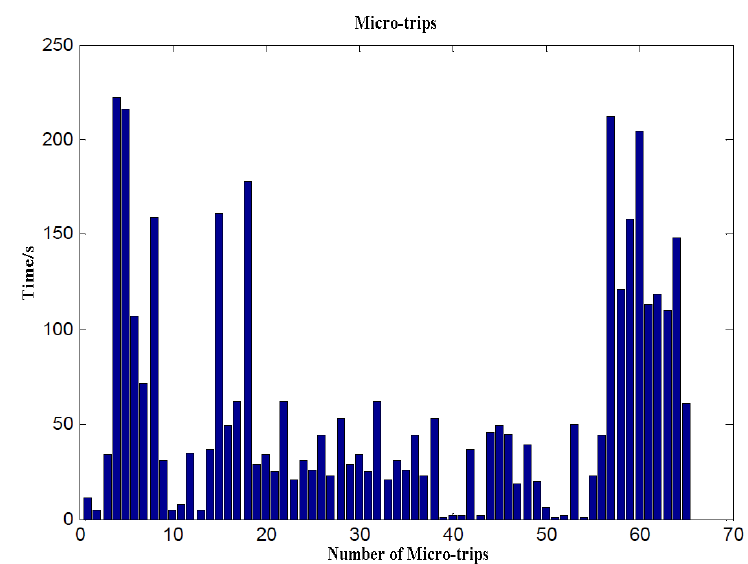
Figure 4. Statistics of micro-trips of driving cycle